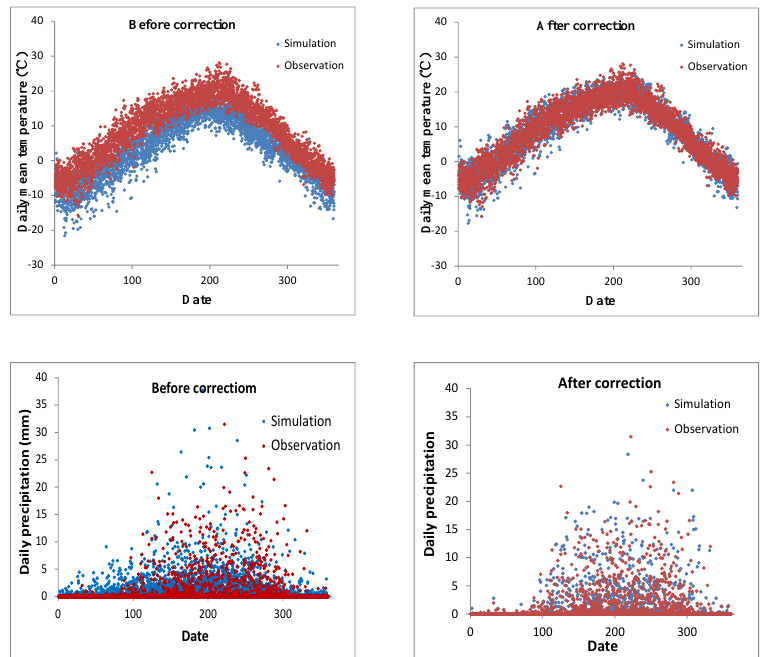
Figure 2. A comparison of observed and RegCM4 simulated daily mean temperatures and precipitation from 2006 to 2015 in Guide station of the Tibetan Plateau, before correction (left) and after correction (right).